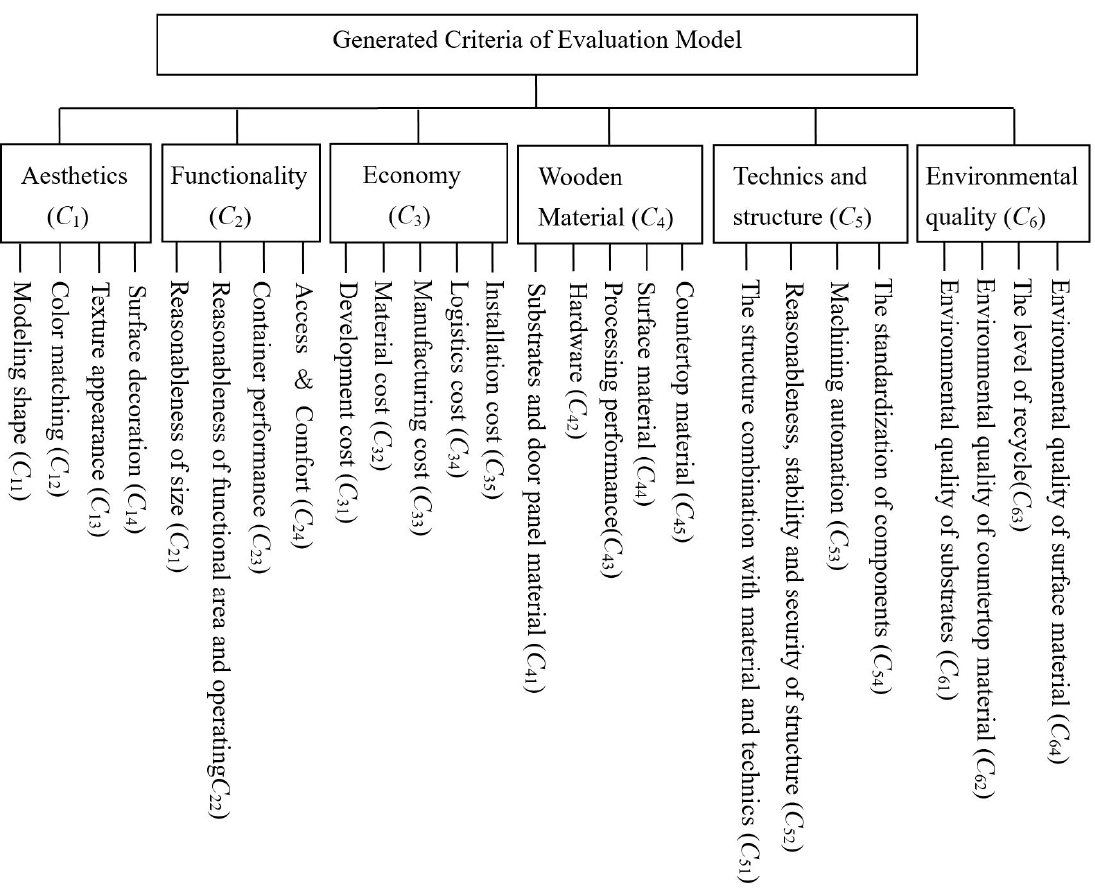
Figure 2. Generated criteria of evaluation model.